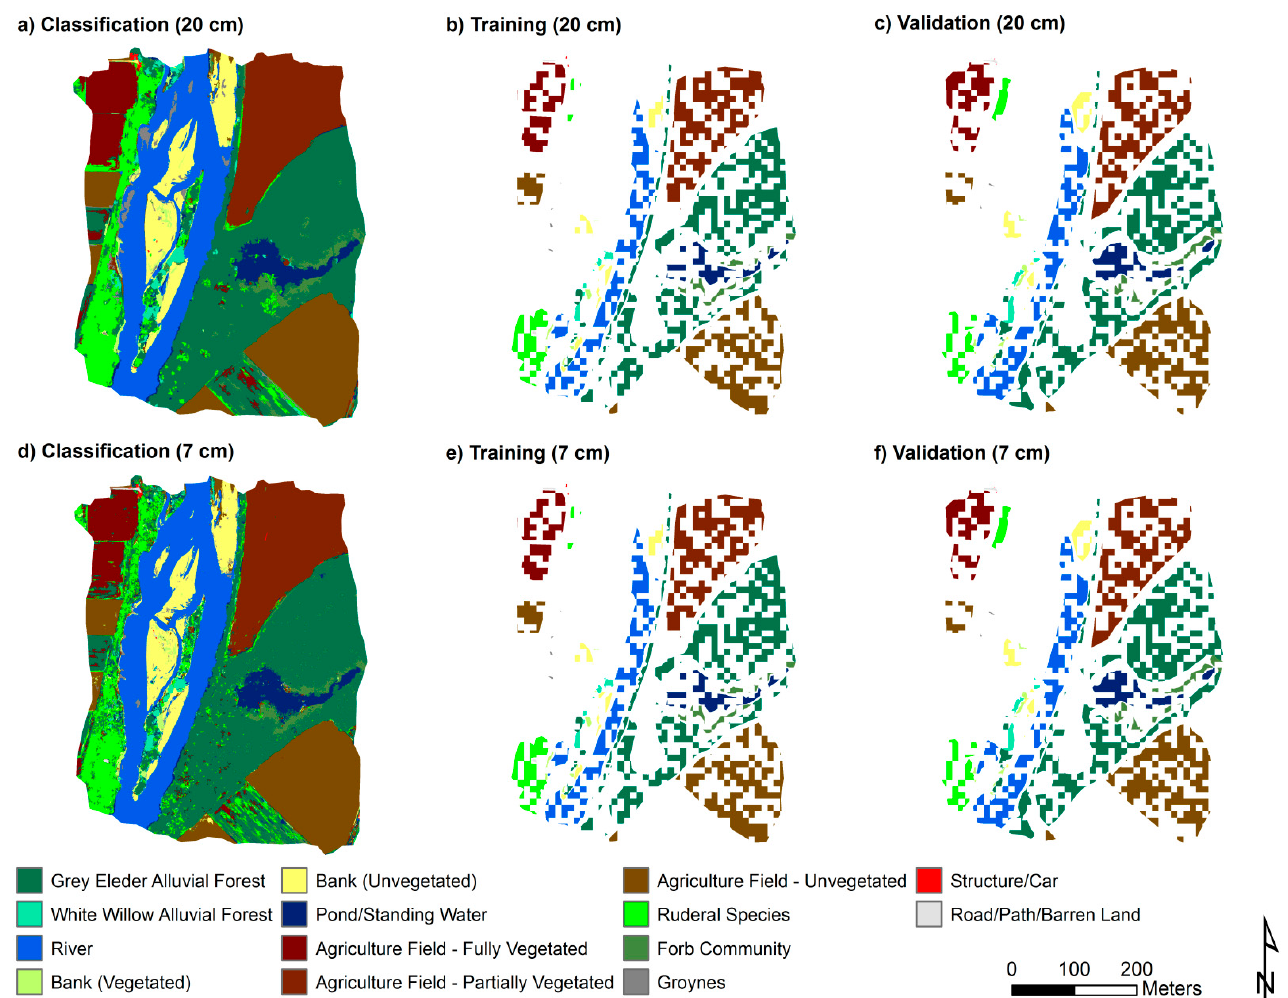
Figure 6. ( a ) Land cover classification of the 20 cm pixel size narrow-band 17 May 2016 image of the River Drau generated using eCognition ® ; ( b ) Training data used in eCognition ® for generating the land cover image in ( a ); ( c ) Validation data used in the accuracy assessment of the land cover image in ( a ); ( d ) Land cover classification of the 7 cm pixel size narrow-band 17 May 2016 image of the River Drau generated using eCognition ® ; ( e ) Training data used in eCognition ® for generating the land cover image in ( d ); ( f ) Validation data used in the accuracy assessment of the land cover image in ( d ).